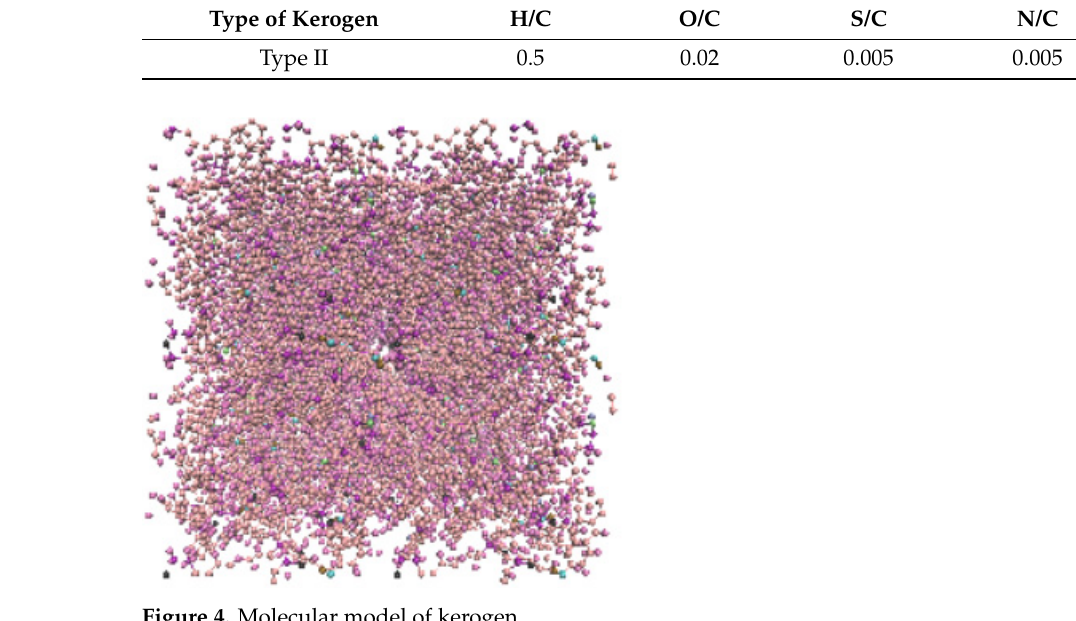
Figure 4. Molecular model of kerogen.